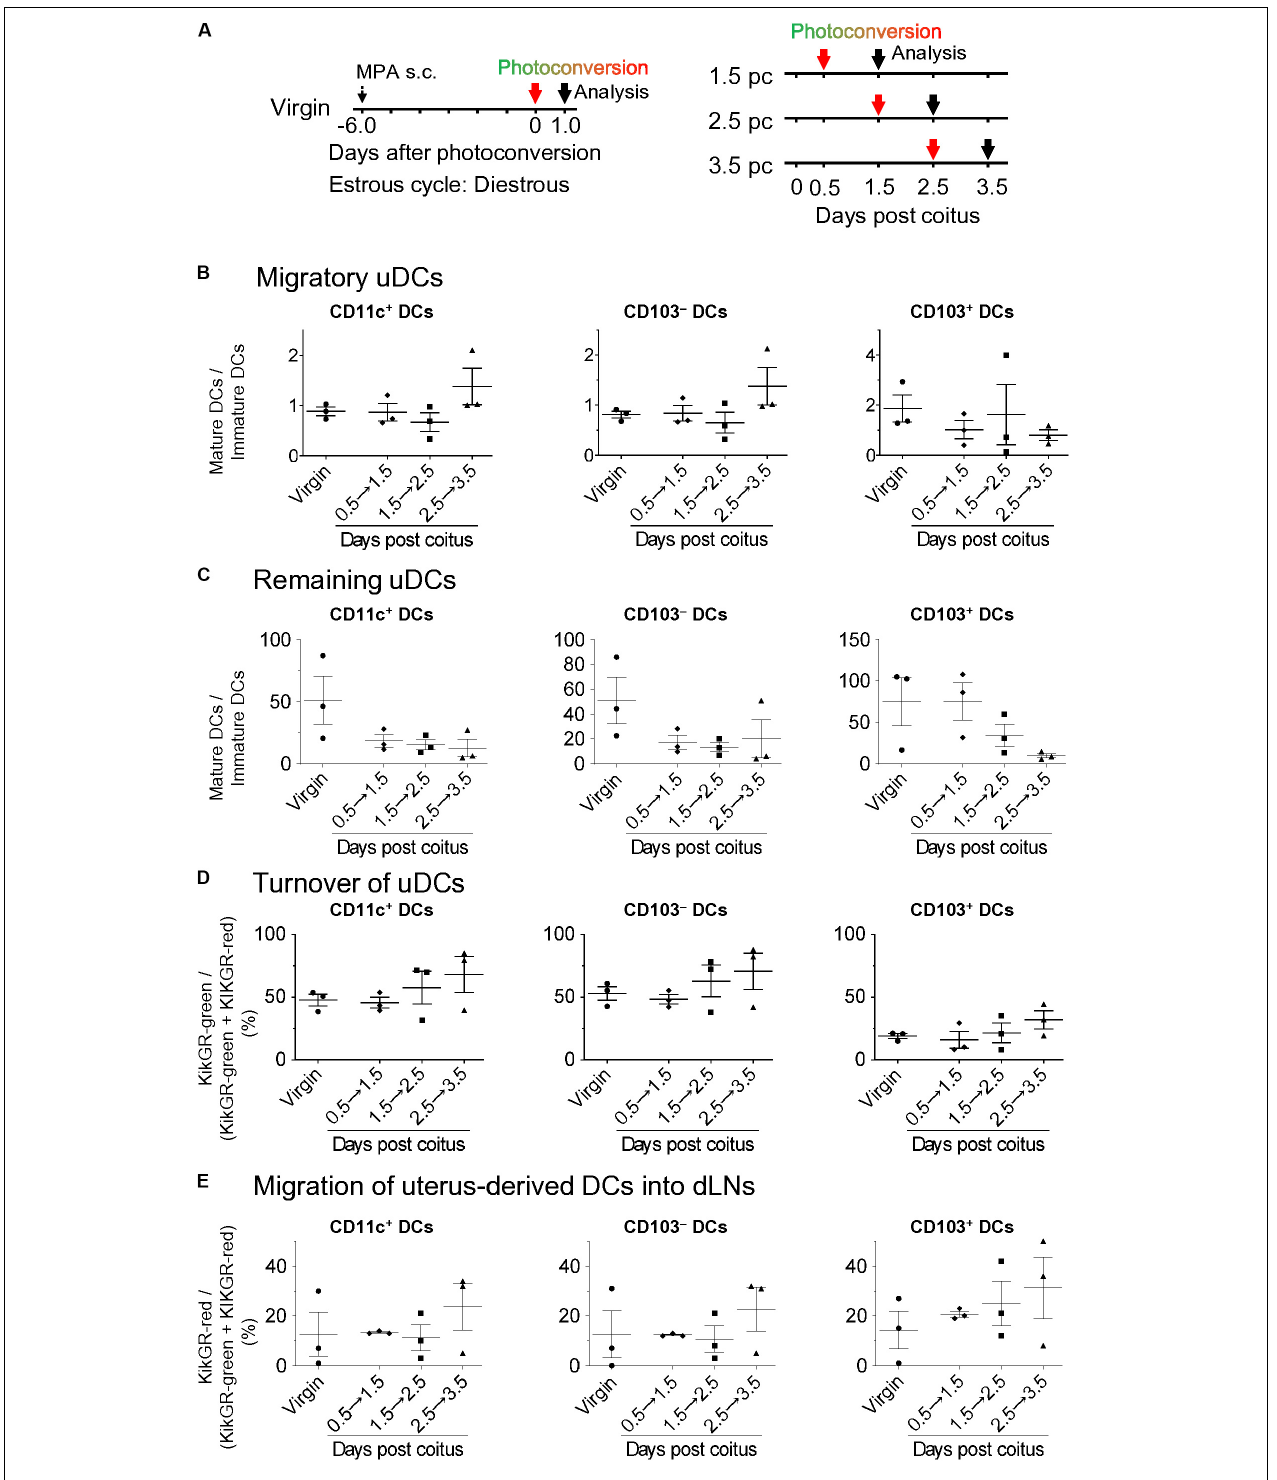
FIGURE 4 | Time course for migratory DCs and remaining DCs in the uterus and dLNs after coitus in allogeneic mating. (A) Experimental time course. Virgin mice were synchronized at the diestrous stage, and the uteri of mice after coitus in allogeneic mating were photoconverted on days 0.5, 1.5, and 2.5 pc. The DCs in the uteri and dLNs were analyzed 24 h after photoconversion. (B–E) Graphs show the ratio of mature DCs/immature DCs (B,C) in each DC subset labeled with KikGR-green (B) and KikGR-red (C) , and proportion of each DC subset labeled with KikGR-green in the uterus, (D) and KikGR-red within MHC class II high DC subset in the dLNs (E) out of the total DCs 24 h after photoconversion. Three samples from each time point were analyzed. Data represent mean ± SEM (B–E) and are representative of three independent experiments. Statistical comparisons were performed using the Kruskal-Wallis test with Dunn’s multiple comparisons test.